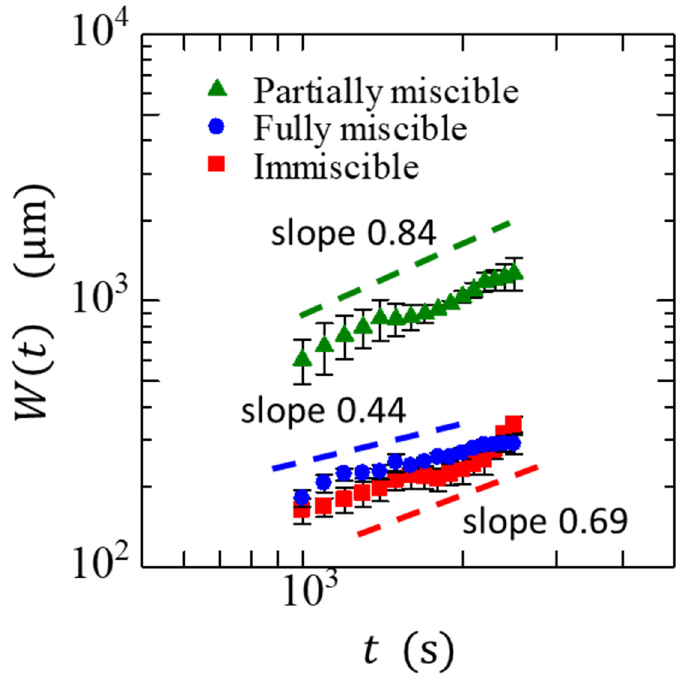
Figure 6. Time evolution of the overall width 𝑊(cid:4666)𝑡(cid:4667) . The various colors indicate different miscibili- ties, and the dashed lines serve as visual guides. The slope is calculated at the region where the value of 𝛼 is constant.